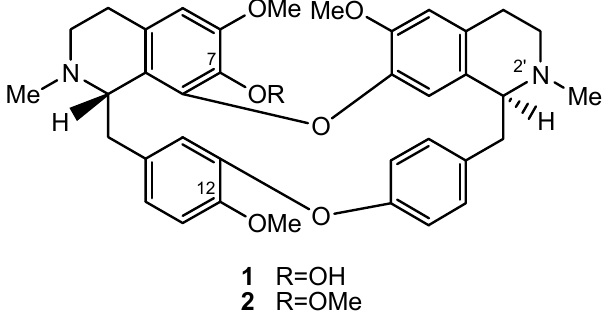
Figure 1. The structures of tetrandrine (Tet, R = OCH R = OH, 2